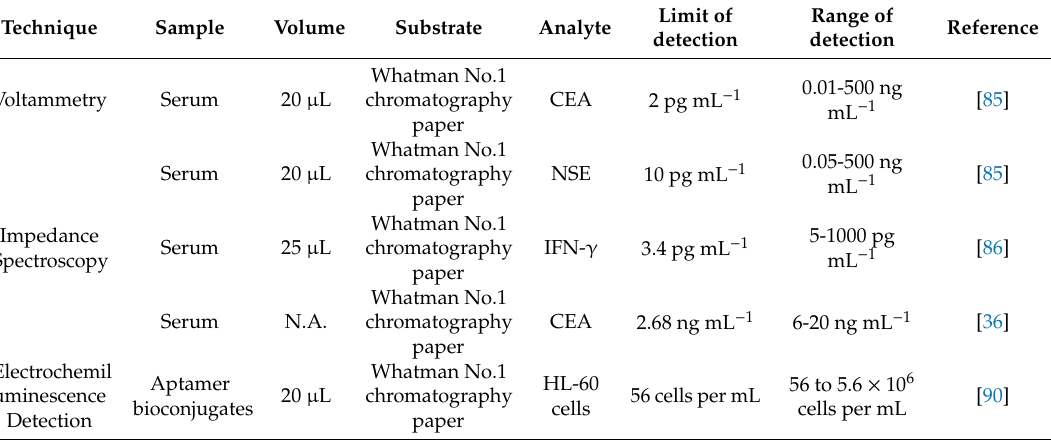
Table 3. Compilation of various electrochemical-based detection techniques used and respective criteria along with results.